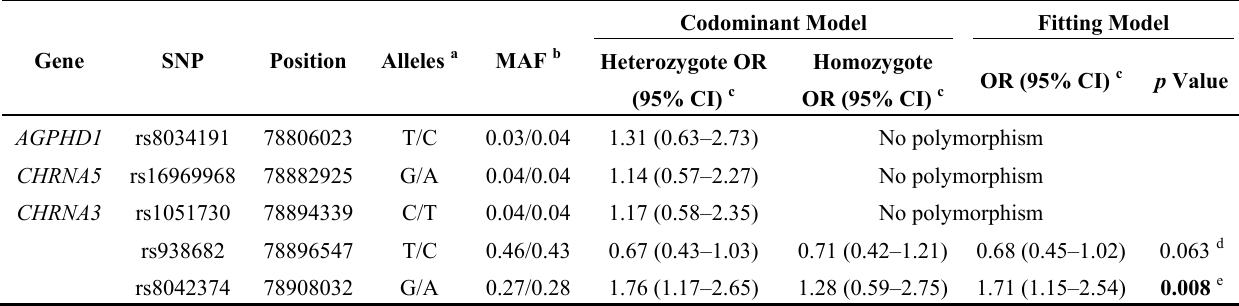
Table 2. Associations between candidate SNPs in 15q25.1 and risk of lung ADC in a Chinese population.